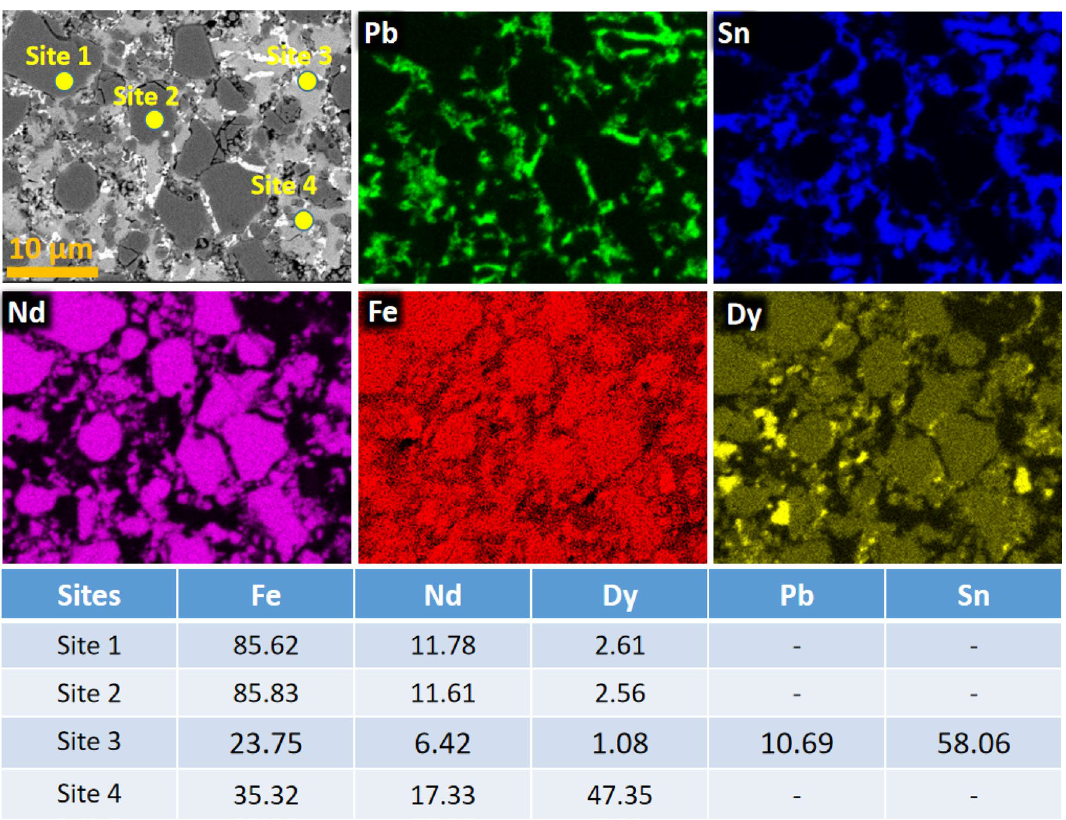
Figure 5. BSE-SEM and BSE-SEM–EDS images of (Nd–Pr) 1.5 Dy 0.5 Fe 14